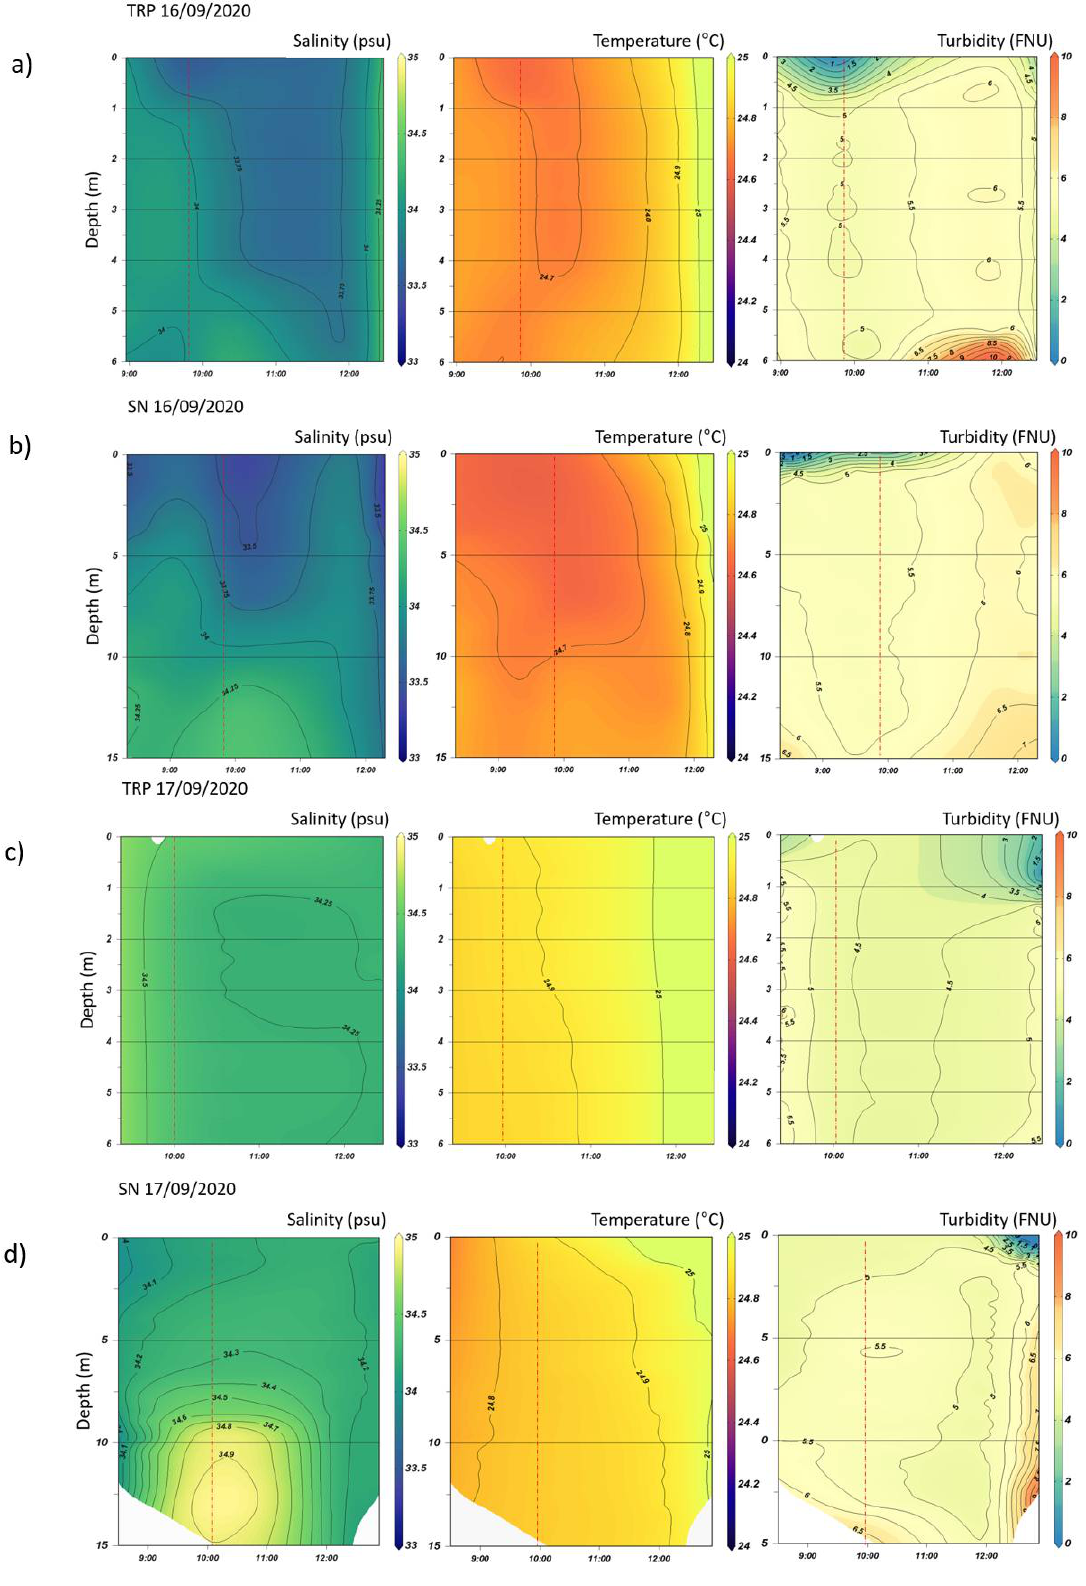
Figure 13. Time series of salinity, temperature and turbidity from CTD casts acquired over the fixed ADCPs at the TRP and SN sections on 16th (( a , b ) respectively) and 17th (( c , d ) respectively) September 2020. Vertical red dashed lines mark the satellites overpass time. Plot generated with Ocean Data View software (https://odv.awi.de, 2021 accessed on 12 July